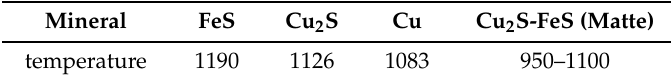
Table 6. Phase transition temperature of the main valuable minerals (°C).